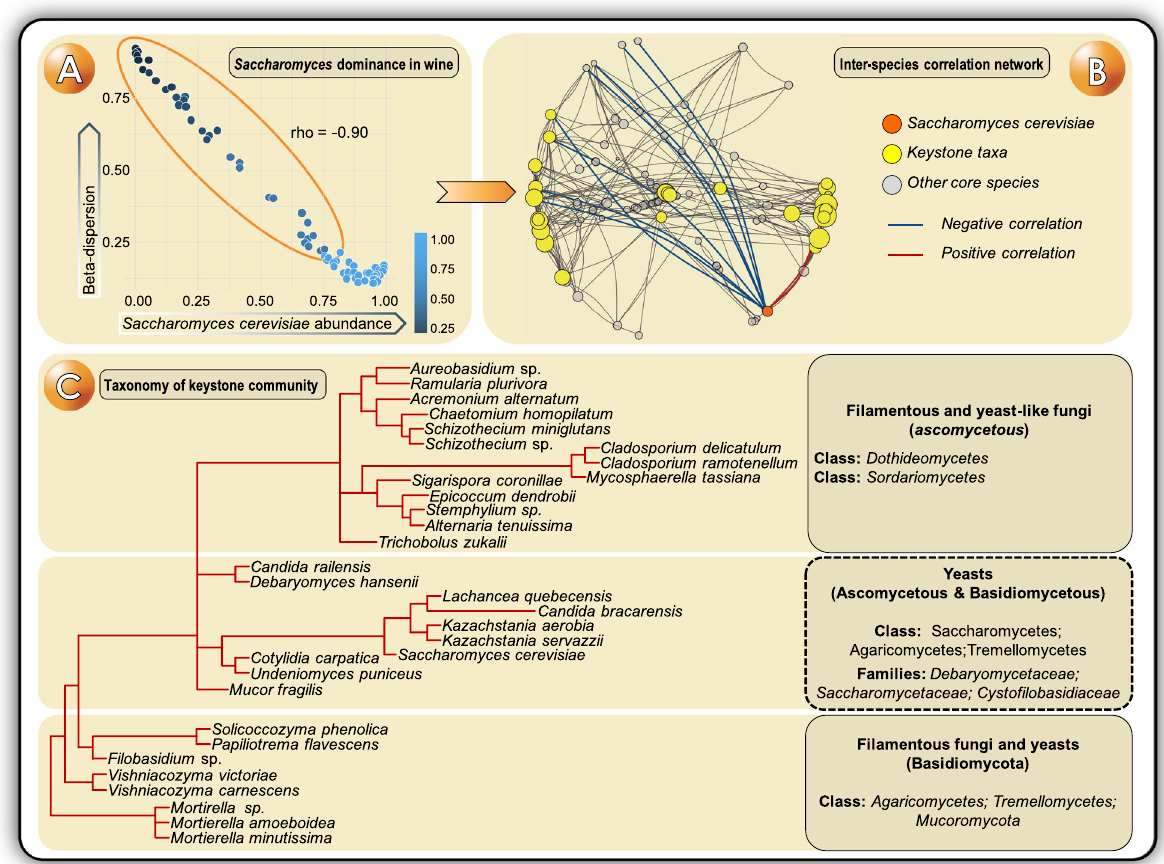
Fig. 2 General fi gures about the core fungal community of wine fermentations, estimated from the regional dataset by Liu et al. 59 (raw data publicly available at PRJNA594469). A As the dominant species in wine fermentations, Saccharomyces cerevisiae abundance has a strong impact in the diversity of fungal communities. B The structure of an inter-species correlation network de fi nes some keystone taxa with a strong potential role in community functioning. Nodes in the network are sized based on their keystone score — calculated as an average of their Mean Degree, Closeness Centrality, and Betweenness Centrality values. Those nodes with higher keystone scores (>0.75) are highlighted as yellow spheres representing keystone taxa. Positive and negative correlations between the abundance of S. cerevisiae (orange node) and other core taxa are highlighted with red and blue edges, respectively. C The taxonomy of the keystone community includes both Ascomycetous and Basidiomycetous fungi including some yeasts, yeast-like and fi lamentous fungi. The particular insights depicted here came from a regional dataset of Australian wine fermentations, but a wider meta-analysis is needed for de fi ning the actual global core mycobiome of wine fermentations and the expectable regional terroir -associated